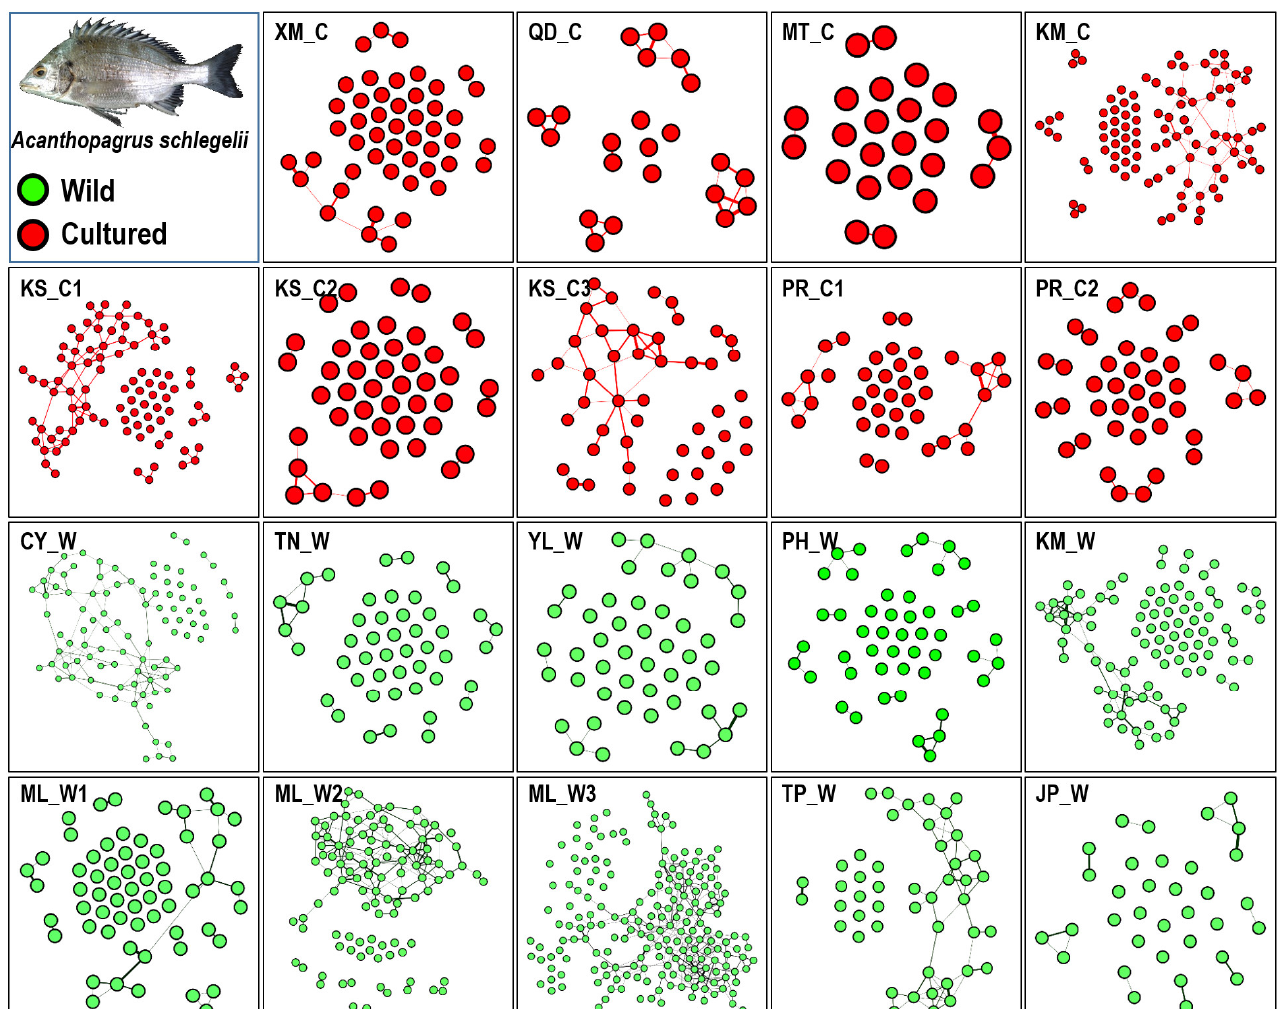
Figure 4. Kinship network based on pairwise relatedness within 19 populations. Wild populations: